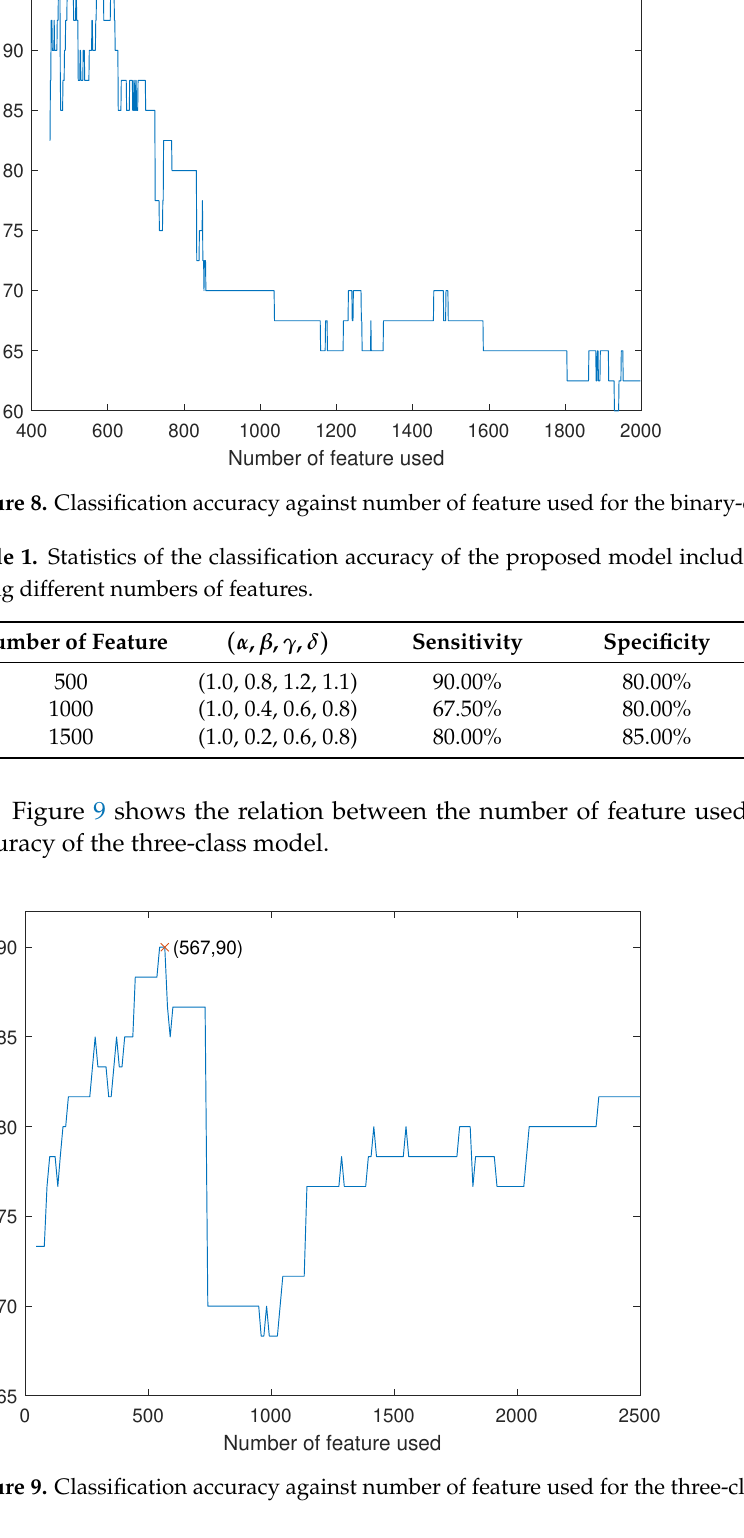
Figure 9. Classification accuracy against number of feature used for the three-class model.